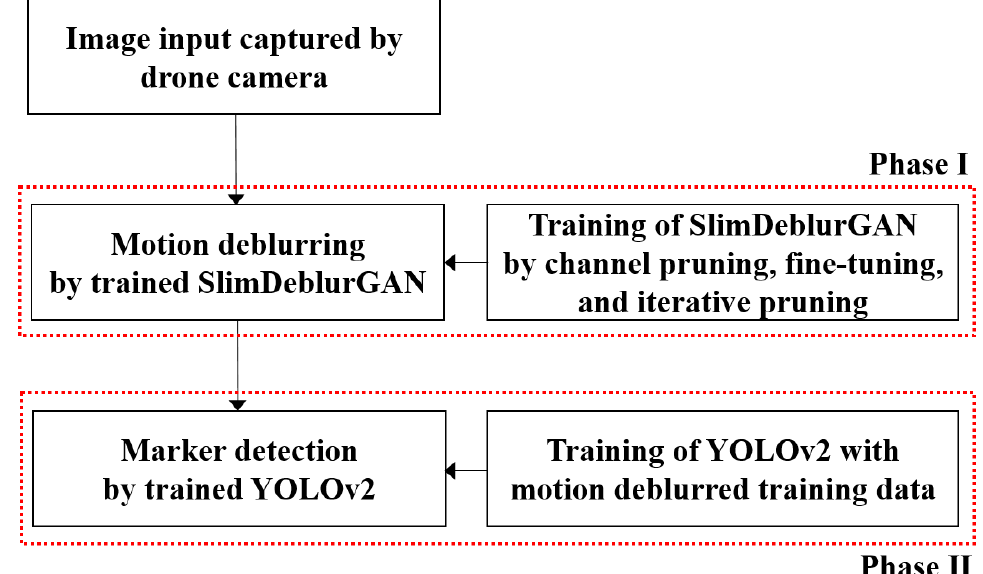
Figure 1. A block diagram of proposed motion deburring and marker detection system.